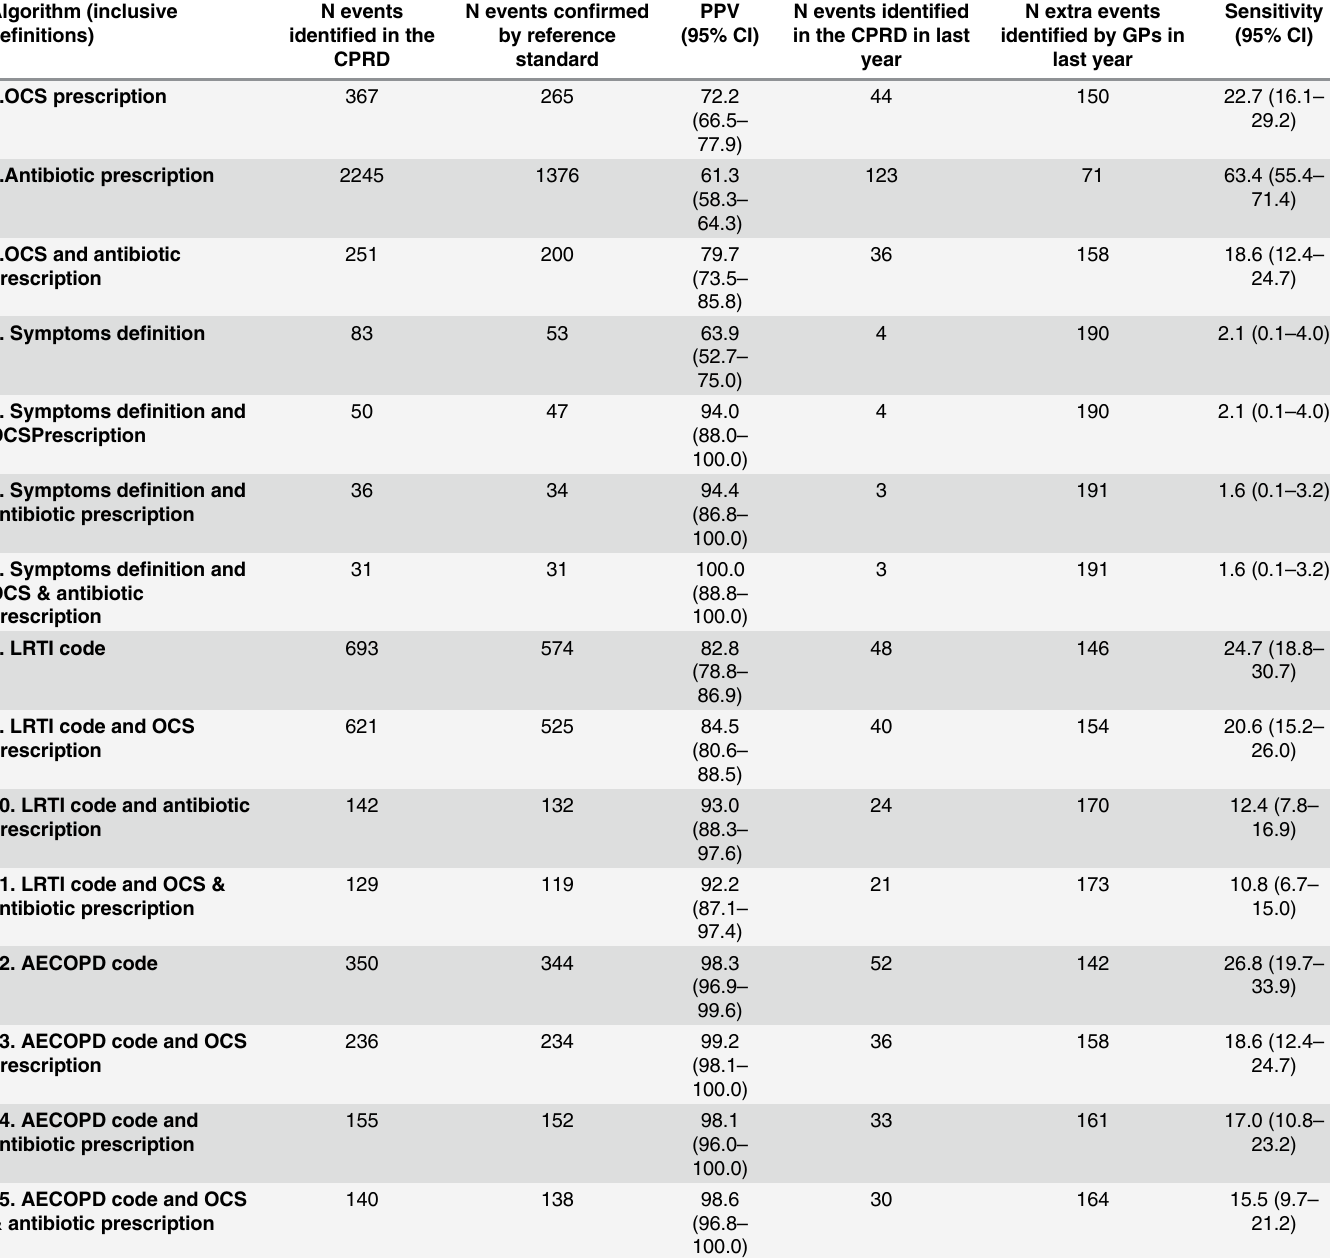
Table 5. PPV and sensitivity of the algorithms to identify AECOPD including only patients for whom additional information was available from their GP questionnaire. Algorithm (inclusive de fi